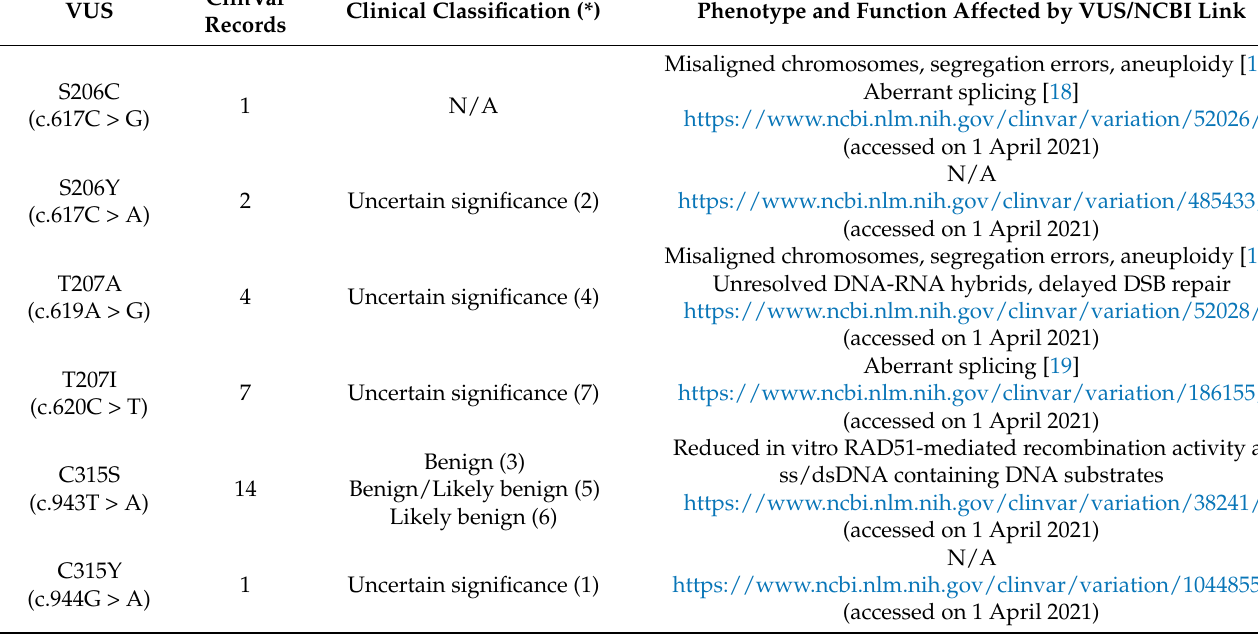
Table 2. Missense VUS reported altering the three BRCA2 residues discussed in this review. VUS protein and DNA nomenclature, number of records in the ClinVar database, current classification, and affected function are indicated together with the original link to the ClinVar database.